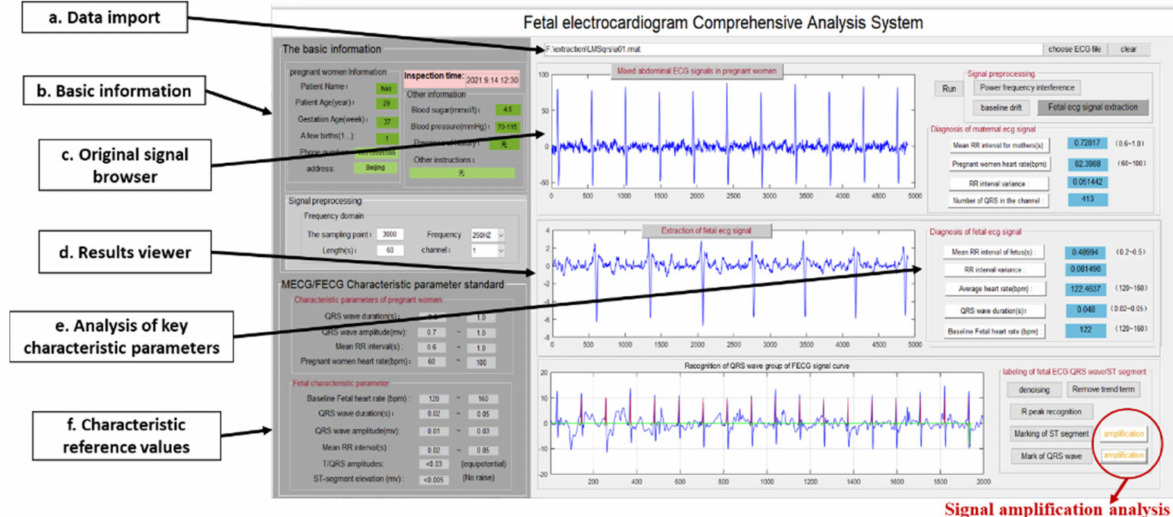
Figure 6. The FECG signal analysis GUI mainly consisted of six parts: (a) Data import; (b) Basic infor- mation; (c) Original signal browser; (d) Results viewer; (e) Analysis of key characteristic parameters; and (f) Characteristic reference values.